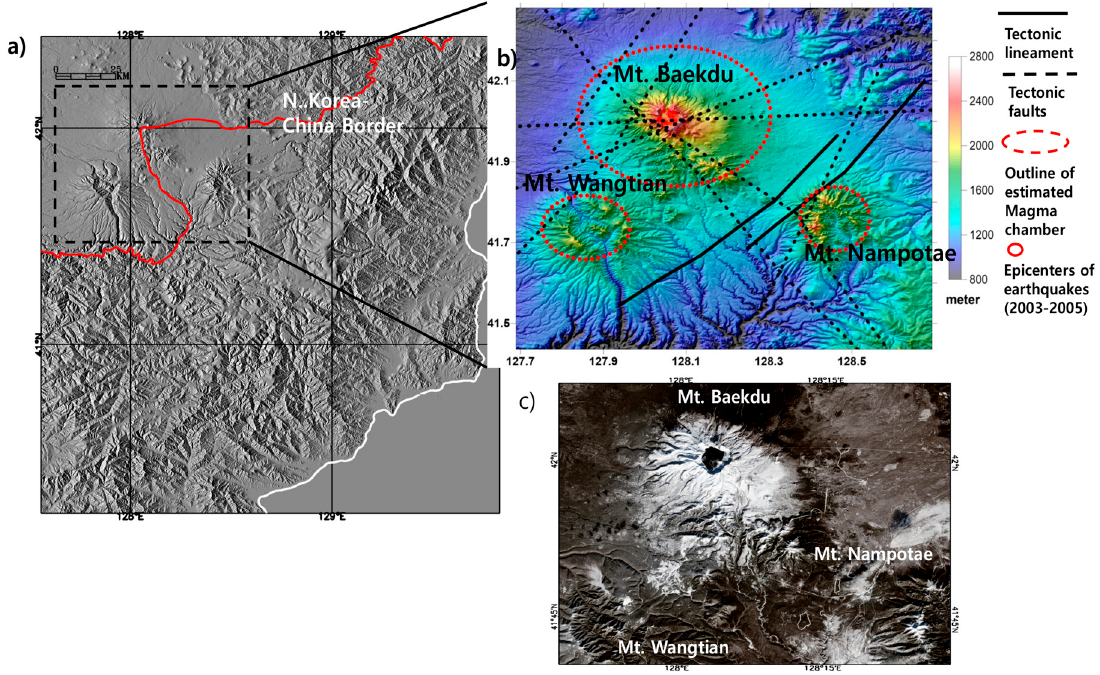
Figure 1. The location of Mt. Baekdu is indicated by a box in ( a ) and the corresponding zoomed-in view of 30m resolution Shuttle Radar Topography Mission (SRTM) DEM is shown in ( b ). The faults lines and the estimated magma chambers from the gravity model in [5] and epicenters of earthquakes [2] are also represented. The Sentinel-2 space-borne image taken in October, 2010 is shown in ( c ). The snow cover, dense vegetation canopy and steep slope around the Cheonji Candela Lake can be observed.